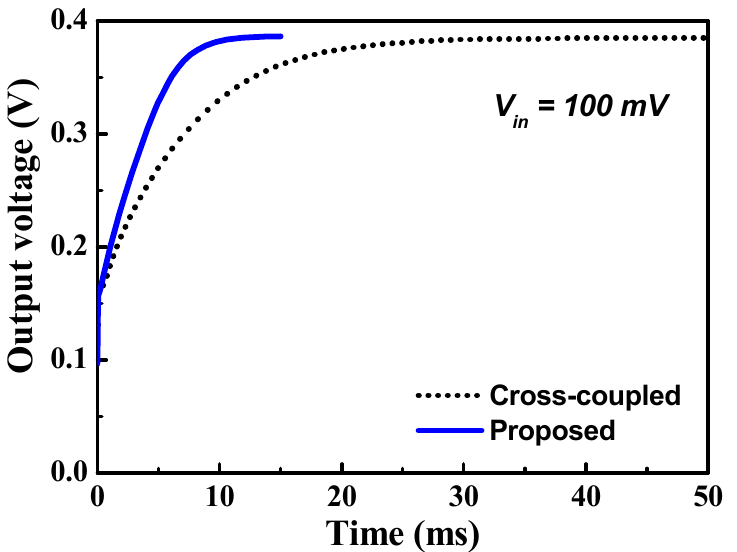
Figure 6. Simulated output voltage of the three-stage cross-coupled charge pump and the proposed charge pump.